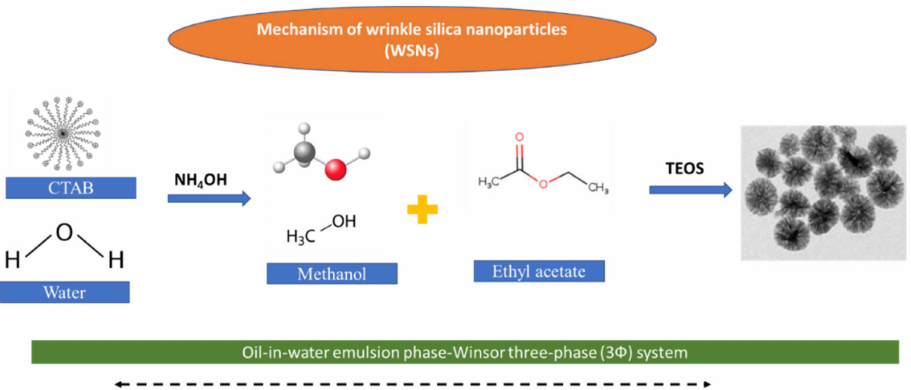
Figure 4. Schematic of wrinkled MSNPs with enlarged